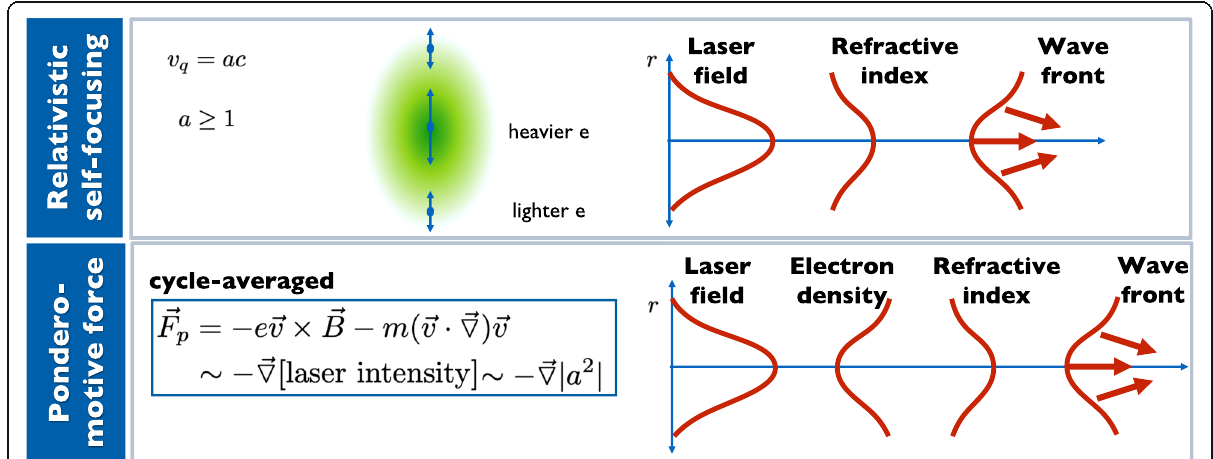
Fig. 10 Description of laser self-focusing in